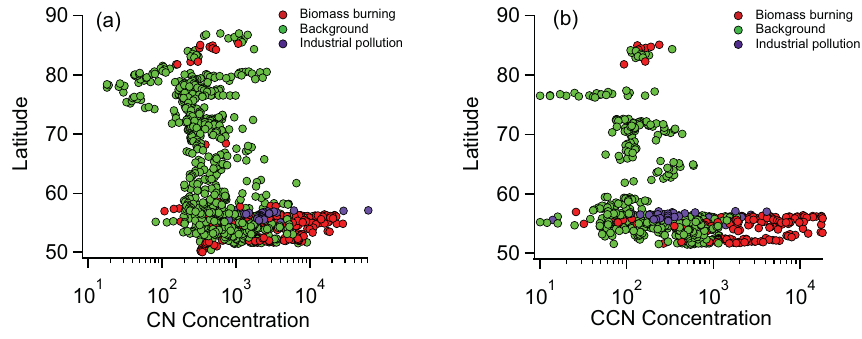
Fig. 4. CN (a) and CCN (b) number concentration (cm − 3 STP) as a function of latitude, colored by source type, for all ARCTAS-B research